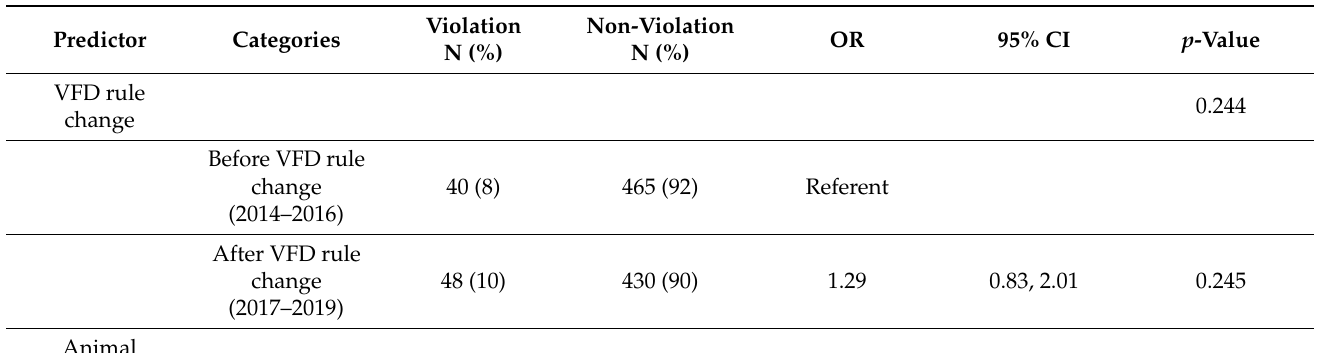
Table 2. Univariable association between predictors and detection of violative residues of tetracycline in the tissue of food animals ( n = 983) from the IGS, 2014–2019.